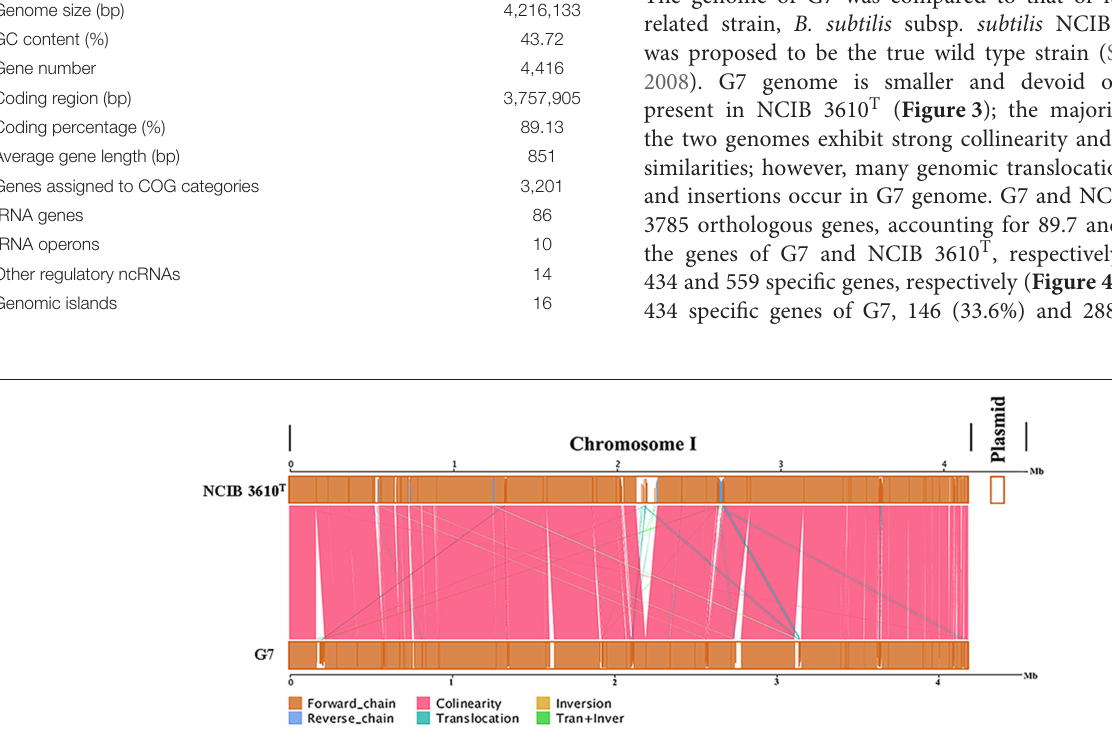
Frontiers in Cellular and Infection Microbiology |